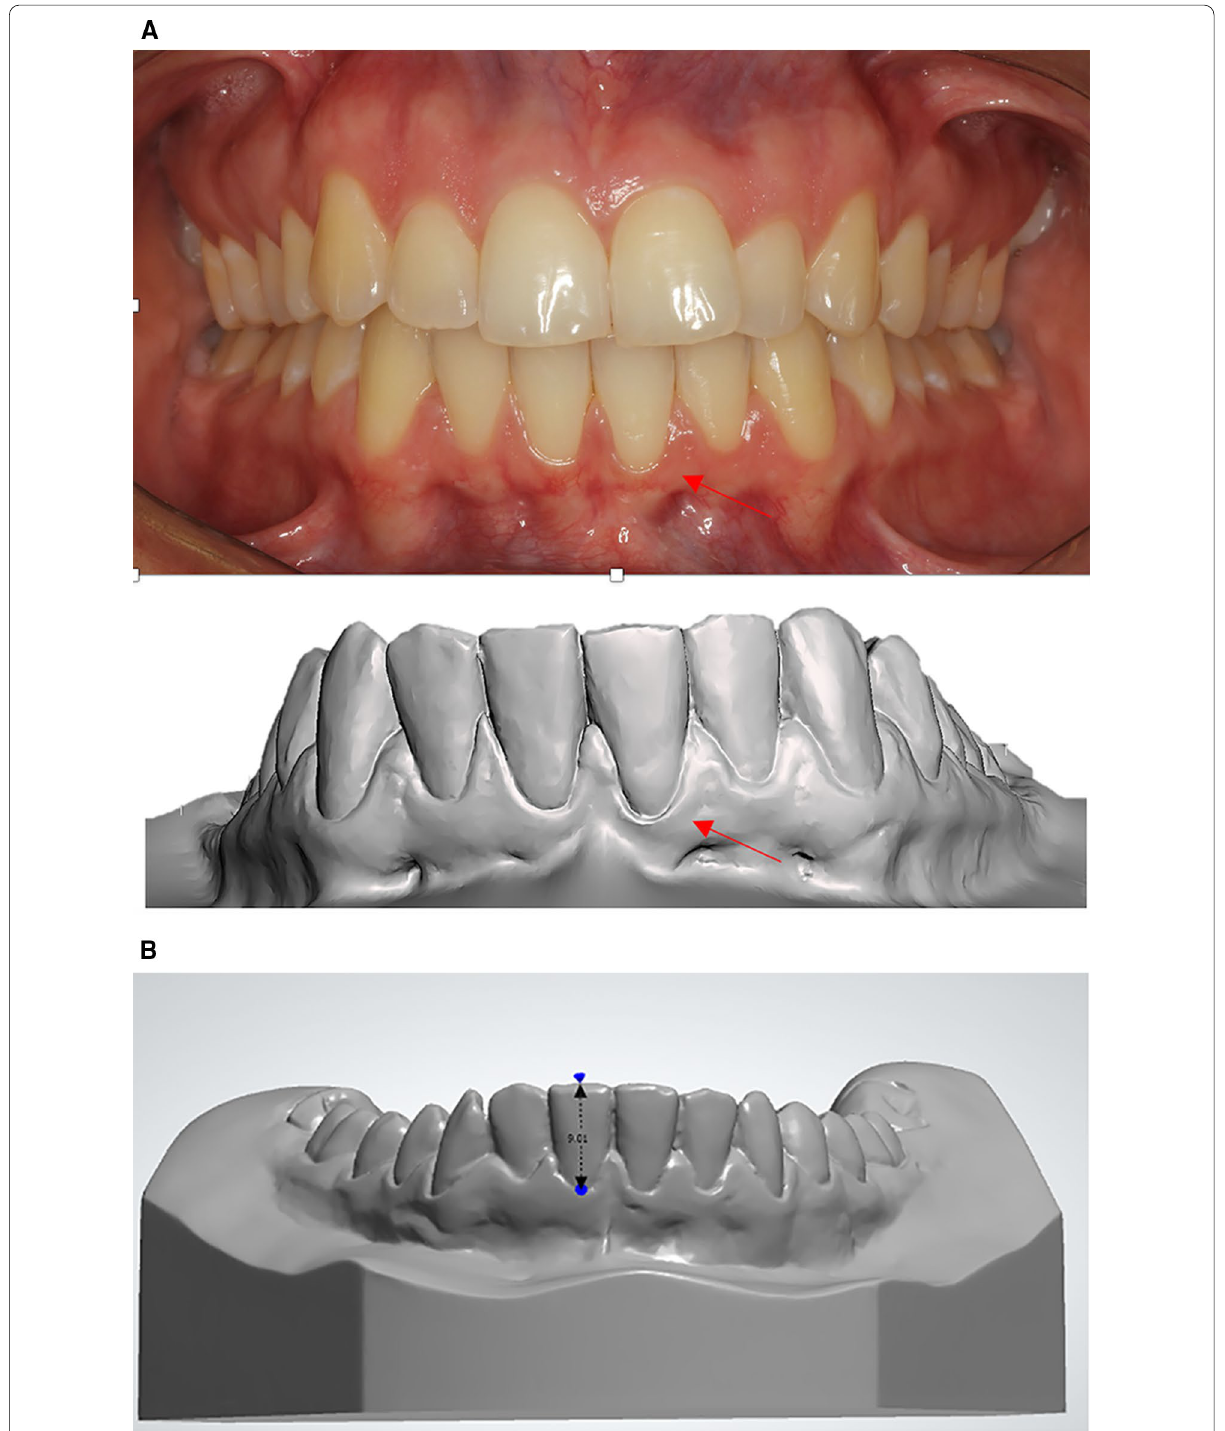
Fig. 1 A Evaluation of the presence of gingival recession: presence of apical displacement of the gingiva below the cementoenamel junction or the labial margin was clearly below the marginal level of the adjacent teeth. B Clinical crown height was measured as a linear measurement between the most apical region of the gingiva and the incisal edge of the mandibular